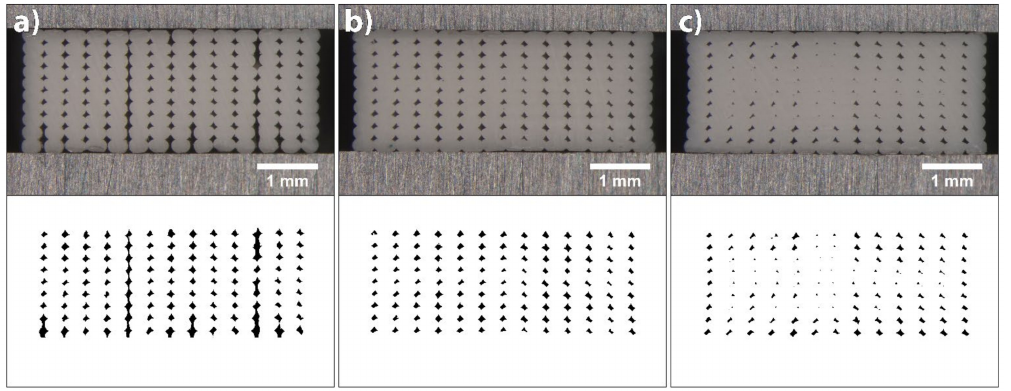
Figure 6. Images of cross-sectional area of 3D printed test samples from PLA and binary images belonging to them at extrusion multipliers: ( a ) 1, ( b ) 1.05 and ( c )